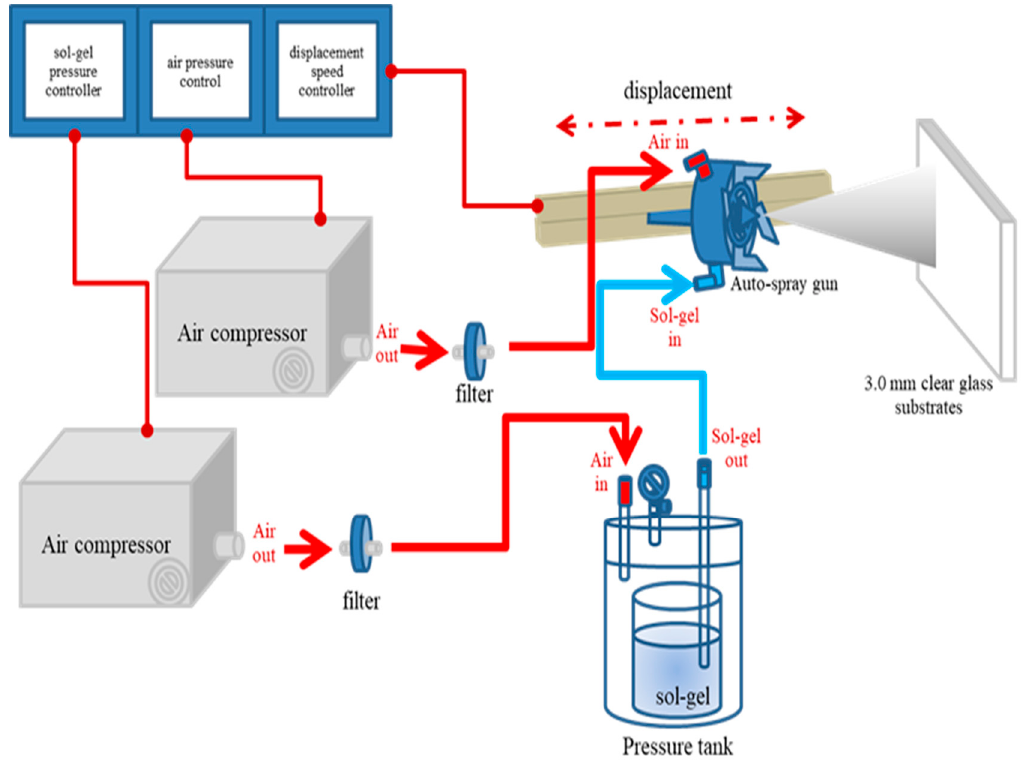
Figure 2. Schematic diagram of the anti-glare thin film production by the auto-spray system.